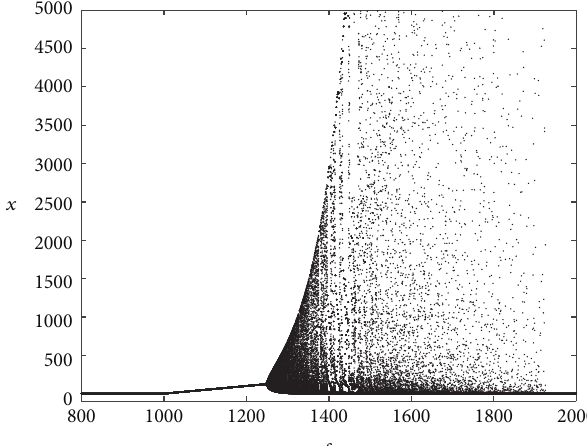
Figure 6: Diagram of bifurcation of the equilibrium points with respect to 𝑥 , for the parameter 𝑠 varying from 800 to 2000, 𝑥 1 = 0.1 , 𝑦 1 = 𝑠 for 𝐴 = 1 , 𝑇 = 1000 , 𝛼 = 0.5 , and 𝑘 = 4